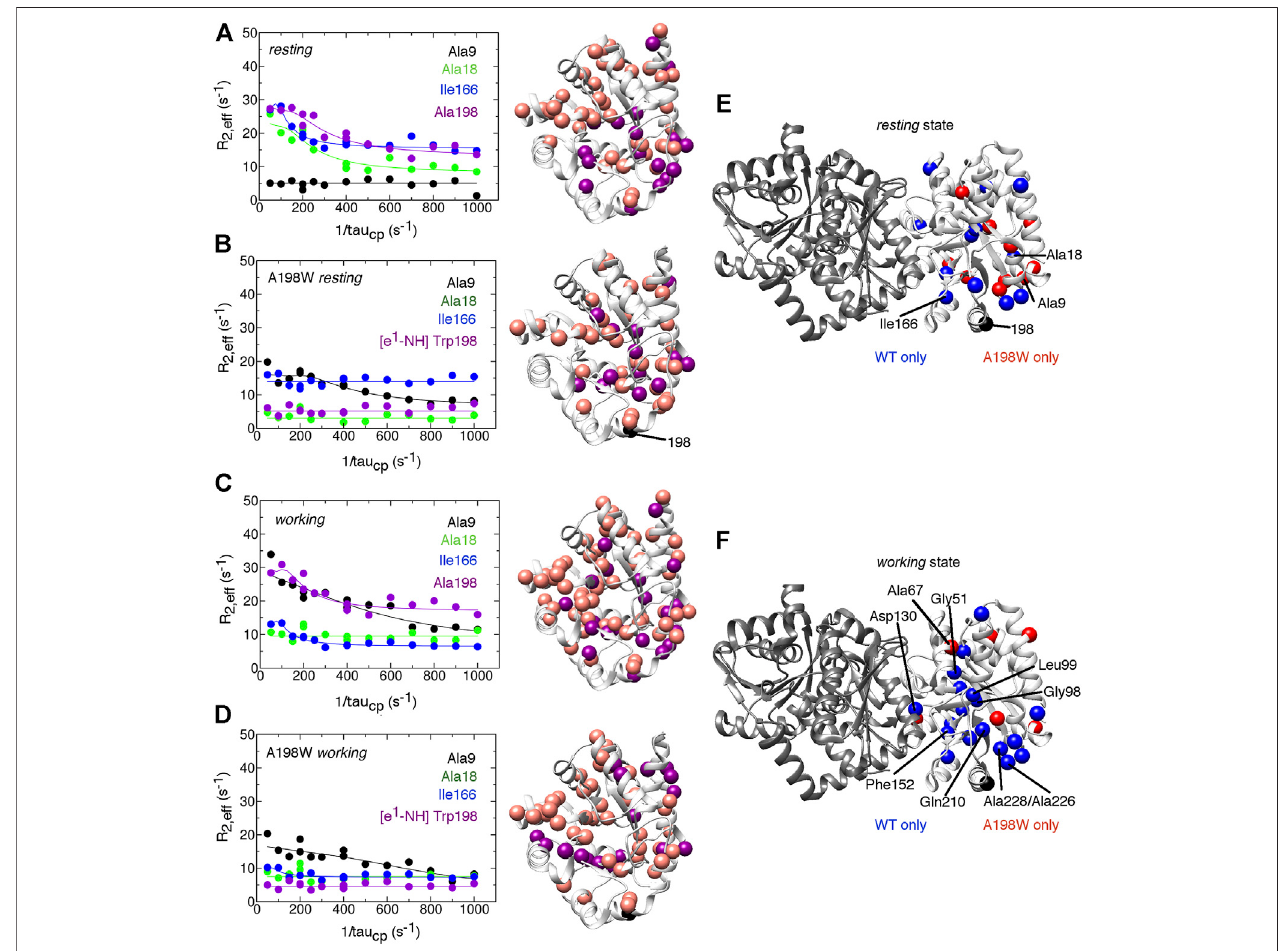
FIGURE4| TheA198W surface-exposed, networksubstitution suppresses millisecond conformationalmotionsin α TS.Conformationalexchangeeventsin E.coli α TS enzyme for (A) WT ligand-free resting , (B) A198W ligand-free resting , (C) WT working and (D) A198W working states. (Left) Example 15 N R curves collected at a 1 H Larmor frequency of 850 MHz for resonances belonging to Ala9 (black), Ala18 (green), Ile166 (blue), and the sidechain ε 1 -NH group of Trp198 (purple). (Right) LocationsofconformationalexchangeaccordingtotheR 2 relaxation dispersion curves plottedasspheresontothe α TSstructure.Purple spheres indicate that associated R 2 relaxation dispersion curves can be fi t to two-site exchange, while pink spheres indicate exchange broadening, but the R 2 relaxation dispersion curves cannot be fi t reliably to two-site exchange. Comparison of the conformational exchange events between WT and A198W α TS for (E) resting and (F) working states is also shown. Blue (red) spheres indicate conformational exchange events present in the WT (A198W) enzyme but not in the A198W (WT) enzyme. It shouldbenotedthattheNMRdatawascollectedintheabsenceof β TS.The 15 NR 2 relaxationdispersionexperimentswereconductedat283 Kusingabufferconsisting of 50 mM potassium phosphate, pH 7.8, 2 mM DTT, 0.2 mM Na 2 EDTA, and 10% 2 H 2 O, and 0.5 – 1.0 mM protein with 10 mM indole, and/or 20 mM G3P, where